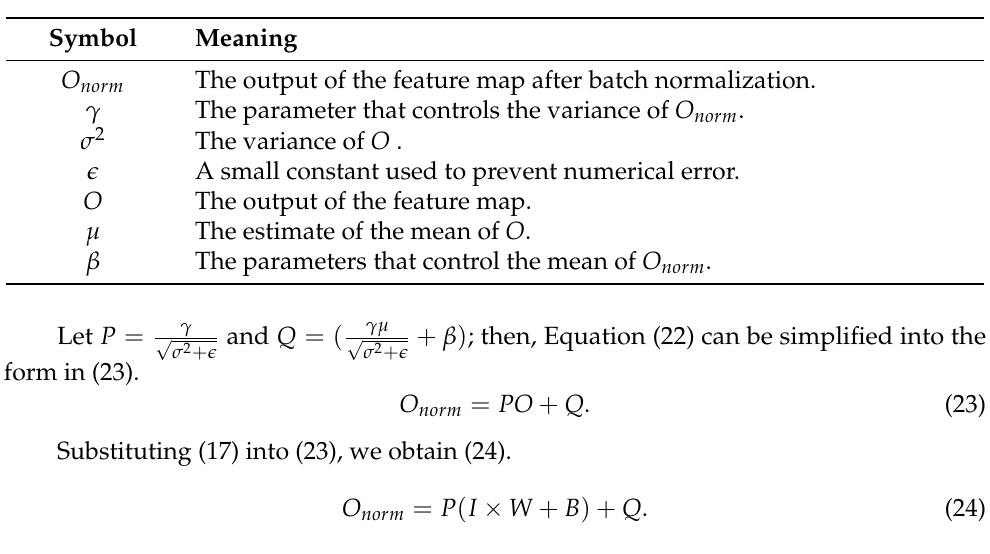
Table 3. Parameter